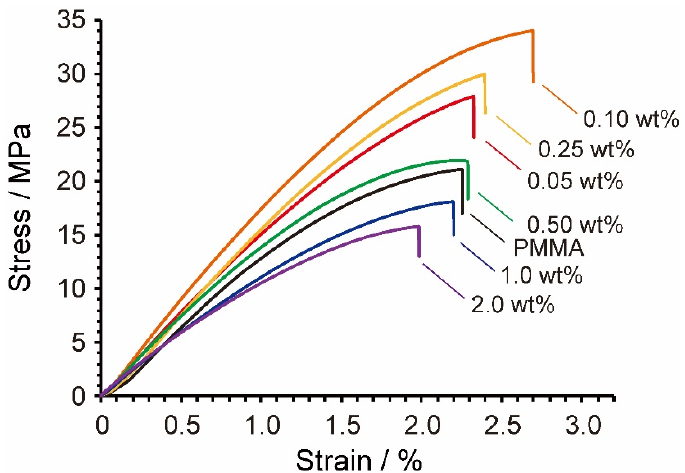
Figure 10. Transmittance spectra of ~0.5 ‐ mm ‐ thick PMMA composite sheets containing 0.05, 0.10, 0.25, 0.50, 1.0, and 2.0 wt% MPC 1, with neat PMMA as a reference.